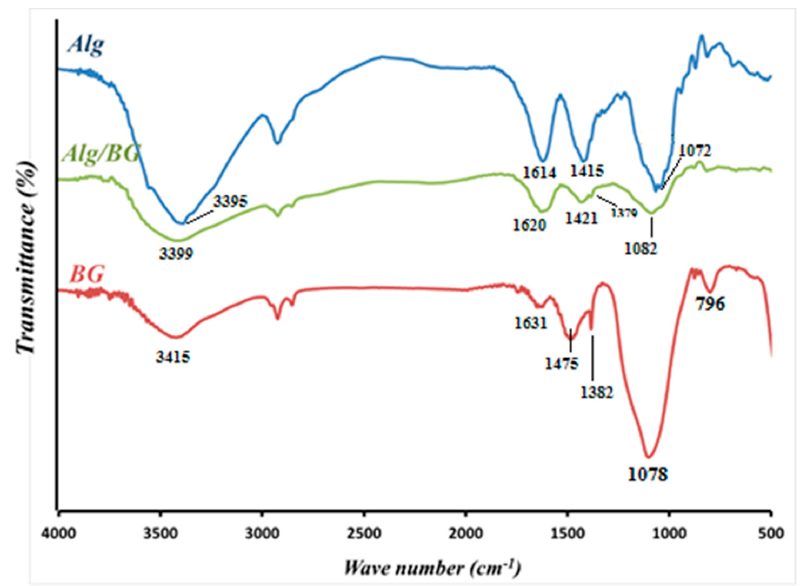
Figure 4. FTIR spectra of Alg (blue), BG (red), and Alg/BG hydrogel (green).